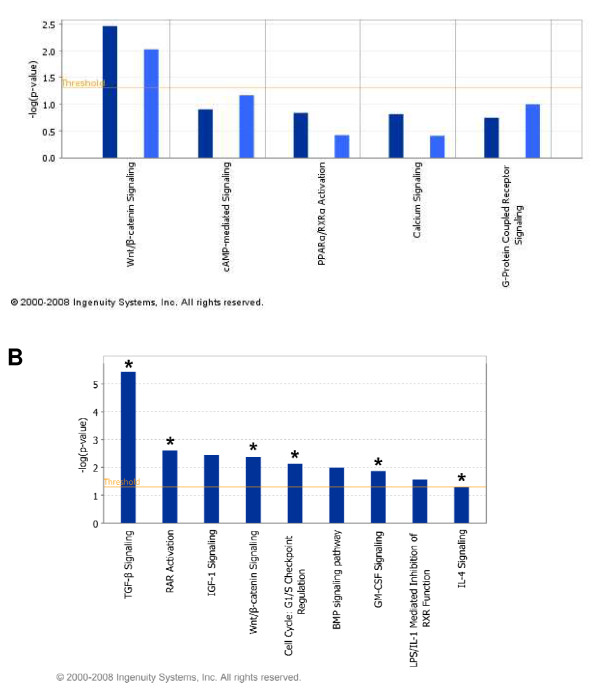
Ingenuity Pathway Analysis of SMAD targets: (A) A graphical representation of overlapping signaling pathways detected in differentially expressed genes and SMAD-target genes. Wnt/β-catenin was found to be significant. (B) The result of Ingenuity analyses of Affymerix gene expression and SMAD-predicted datasets. There are total nine significant signaling pathways (shown in bar graphs) for gene expression data, and six significant signaling pathways for SMAD-predicted molecules (shown by asterisks). There is a major functional overlap (about 70% or 6/9) between gene expression and SMAD-predicted data. Note that the p values were calculated by Ingenuity algorithm  per each pathway within Affymerix gene expression dataset and minus log p values are shown. The minus log p values for SMAD-predicted molecules are not shown.